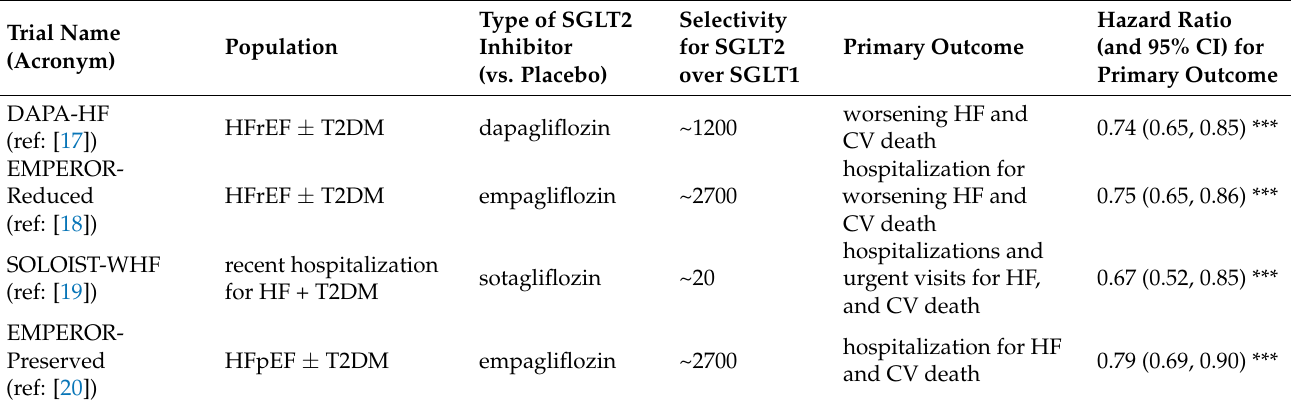
Table 2. Summary of large-scale dedicated heart failure (HF) trials with sodium–glucose cotransporter 2 (SGLT2) inhibitors and the dual SGLT1/2 inhibitor